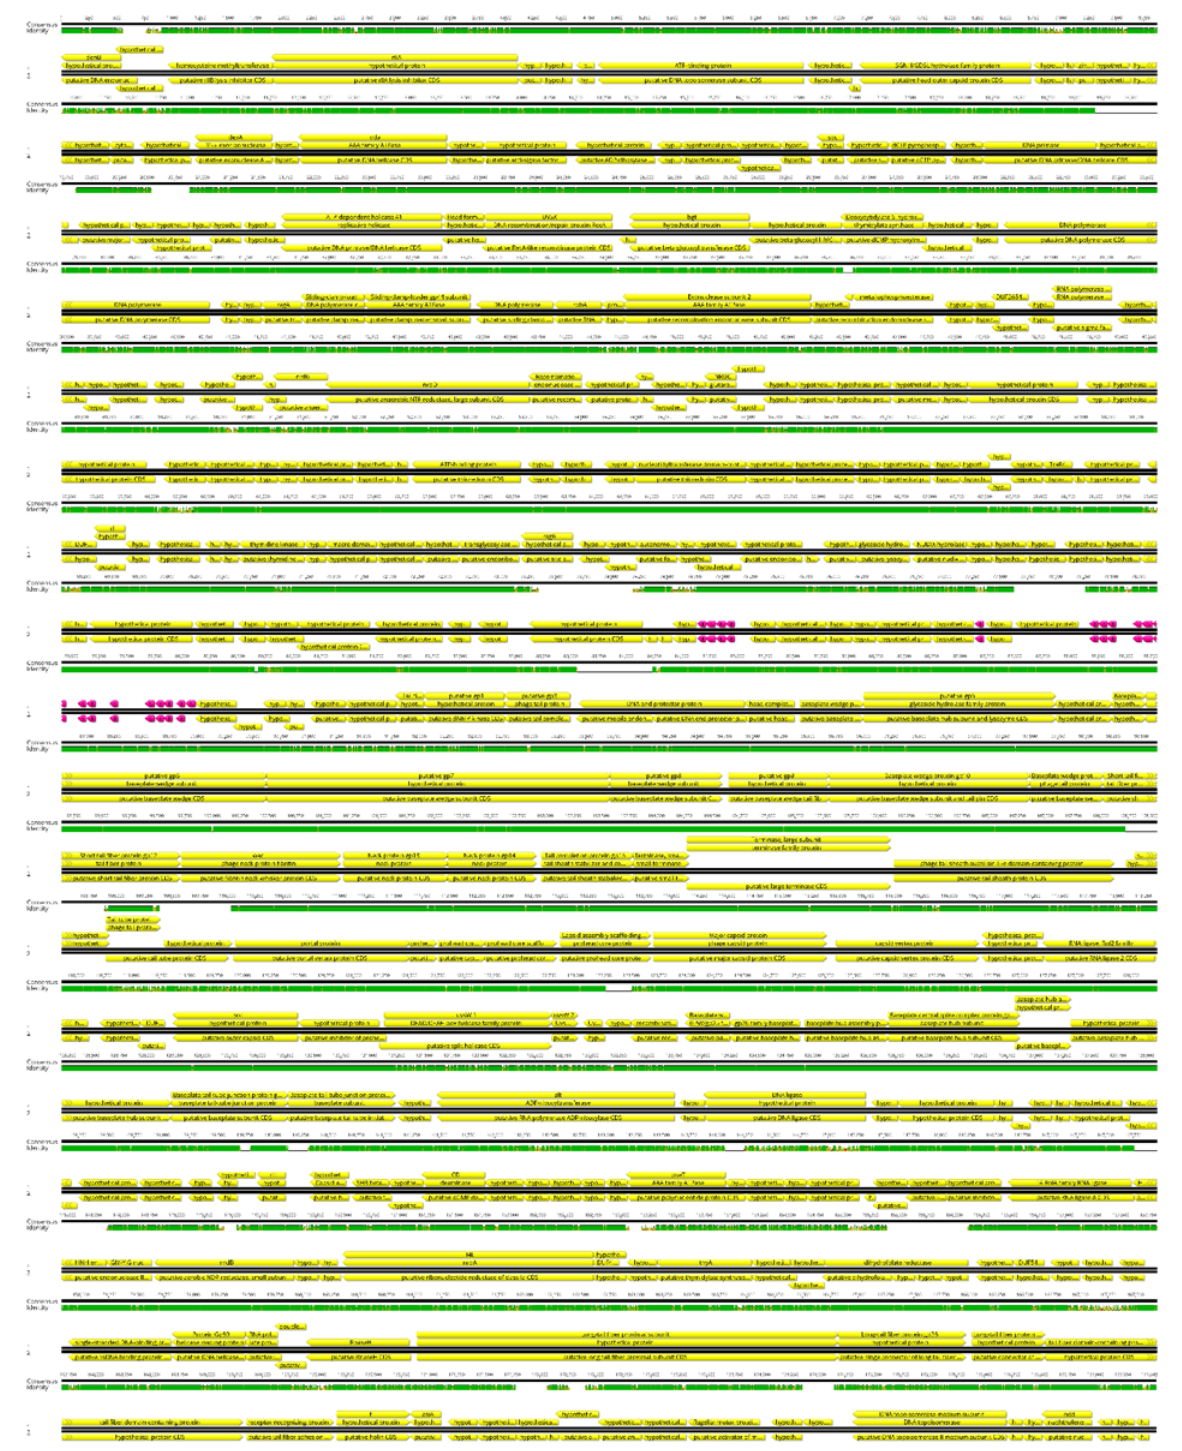
Figure 4. Graphical representation of phage Entb_43 (no. 1), aligned to the most similar known genome of Klebsiella phage vB_KaeM KaAlpha (no. 2, acc. no. MN013084). Green—100%, brown- green—between 30% and 100%, and red—0% local similarity. Lack of color shows a gap in alignment. Annotation is shown for reference. Coding sequences (CDS) are yellow, and tRNA coding sequences are pink.